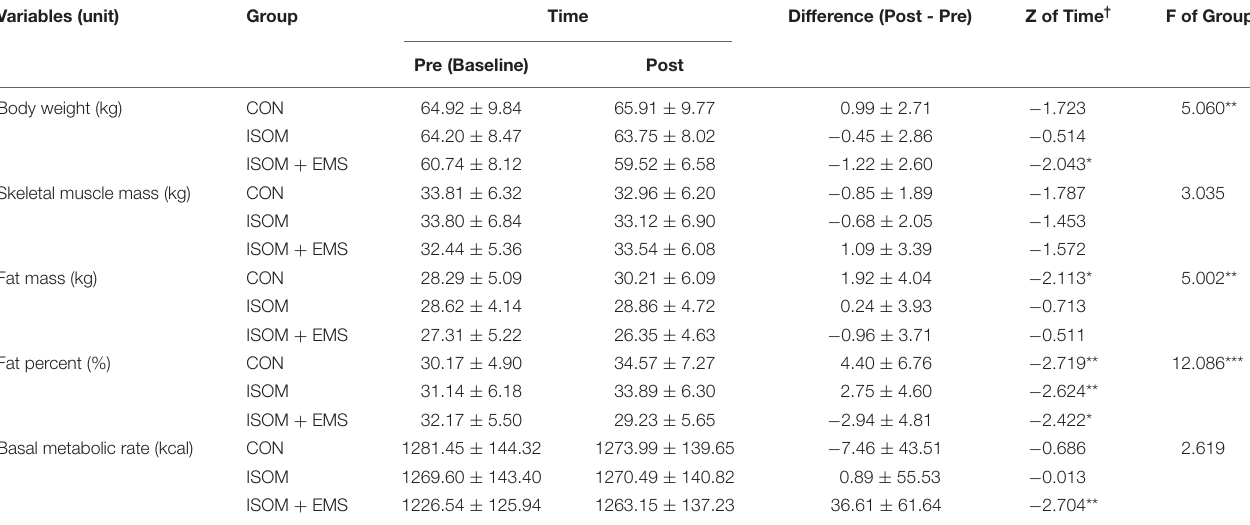
TABLE 5 | Differences and Changes in Body composition and Anthropometric